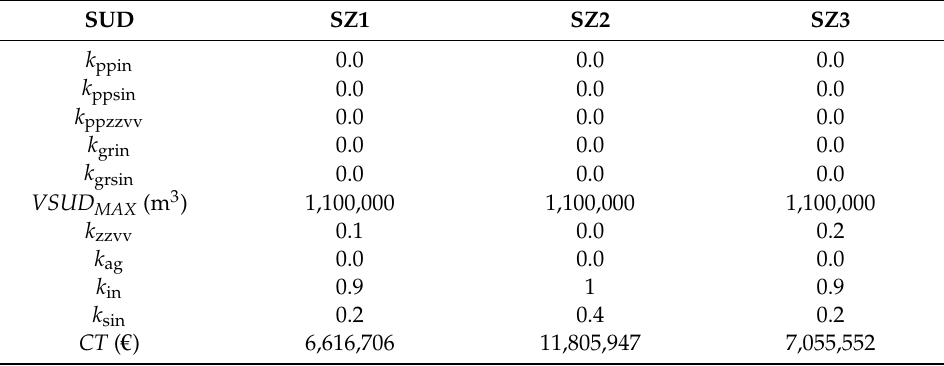
Table 9. Optimal combination of SUDs by catchment.